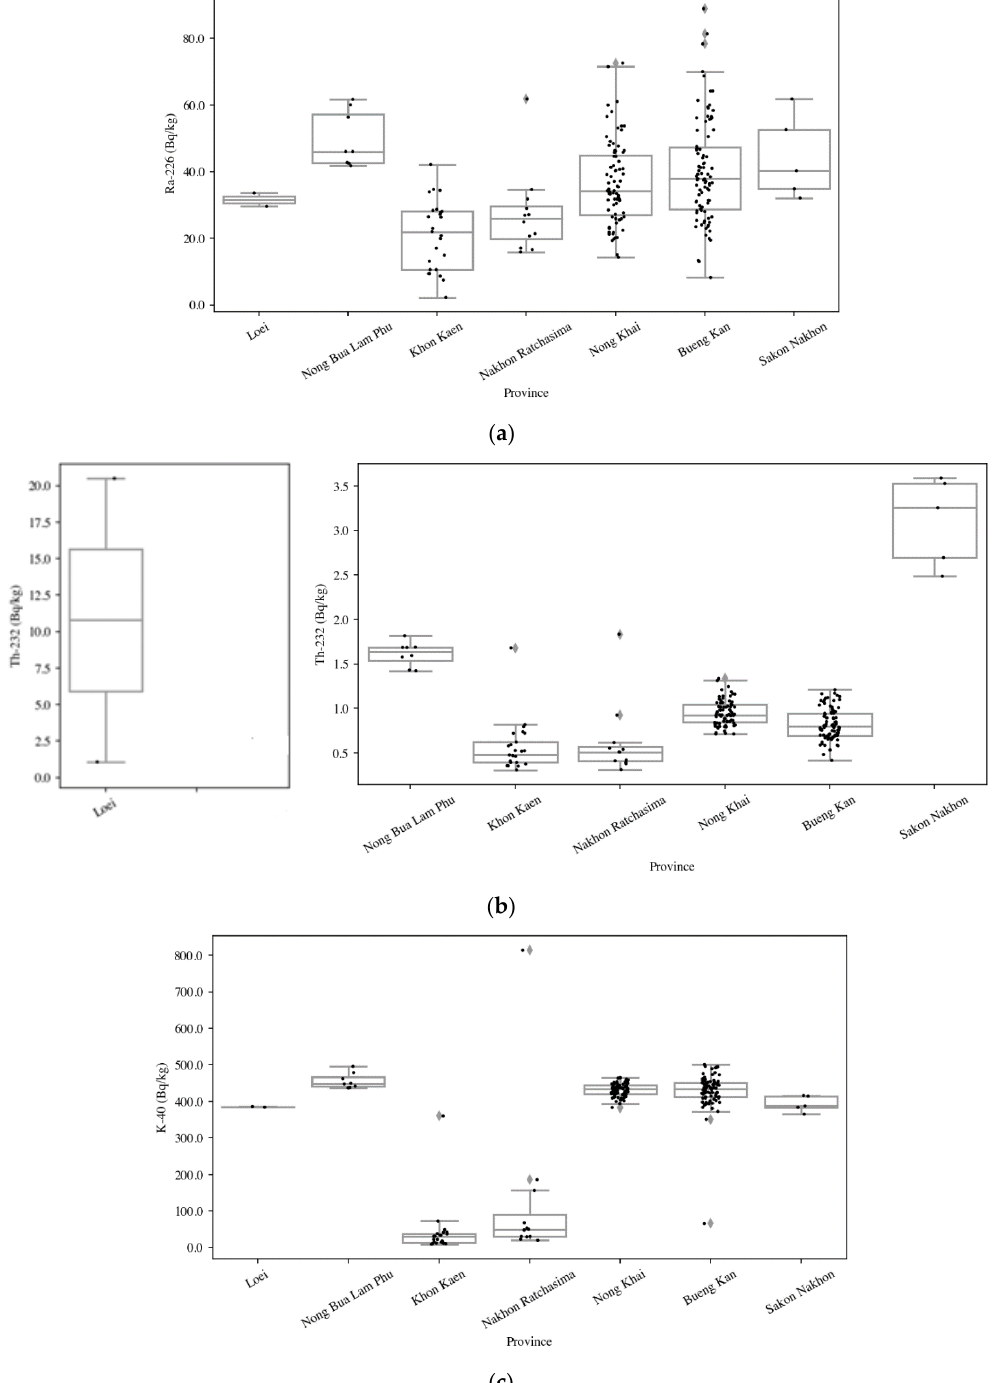
Figure 3. The activity concentrations of Ra-226 ( a ), Th-232 ( b ), and K-40 ( c ) in sand samples. The box represents the middle 50% of measurements (2nd and 3rd quartiles). The middle line represents the median dividing those quartiles. The whiskers represent the bounds of the remaining two quartiles. Data points outside the whisker range are